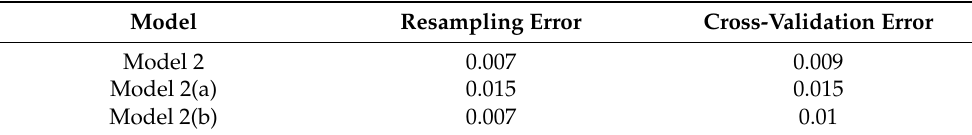
Table 2. The resampling error and cross-validation error values of decision model 2.